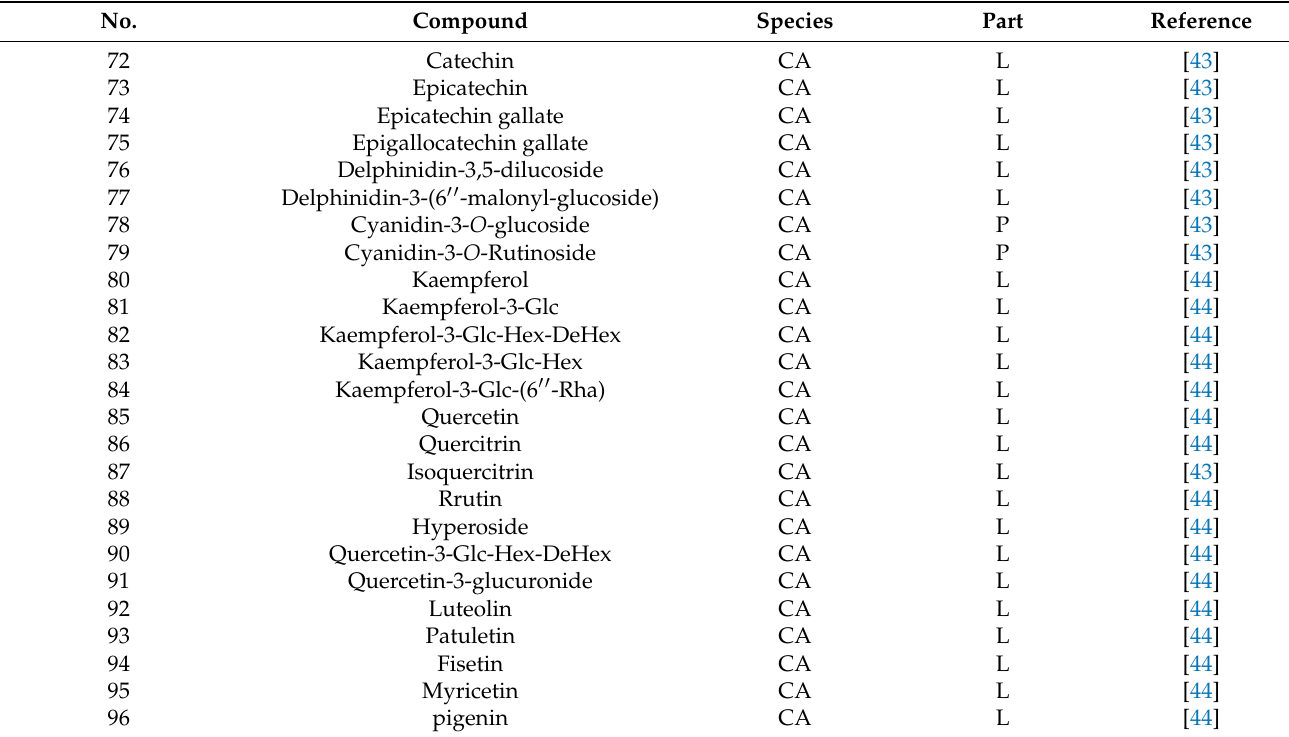
Table 4. Flavonoids compounds in